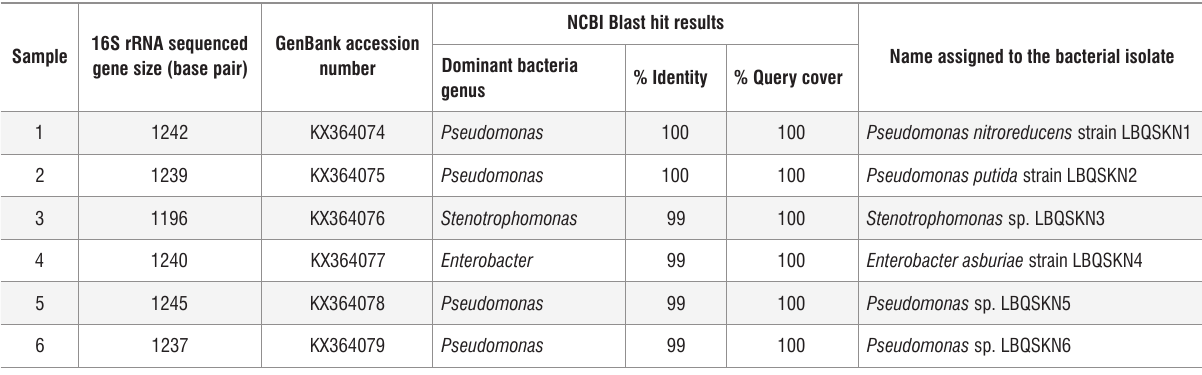
Table 1: Bacterial isolates identified